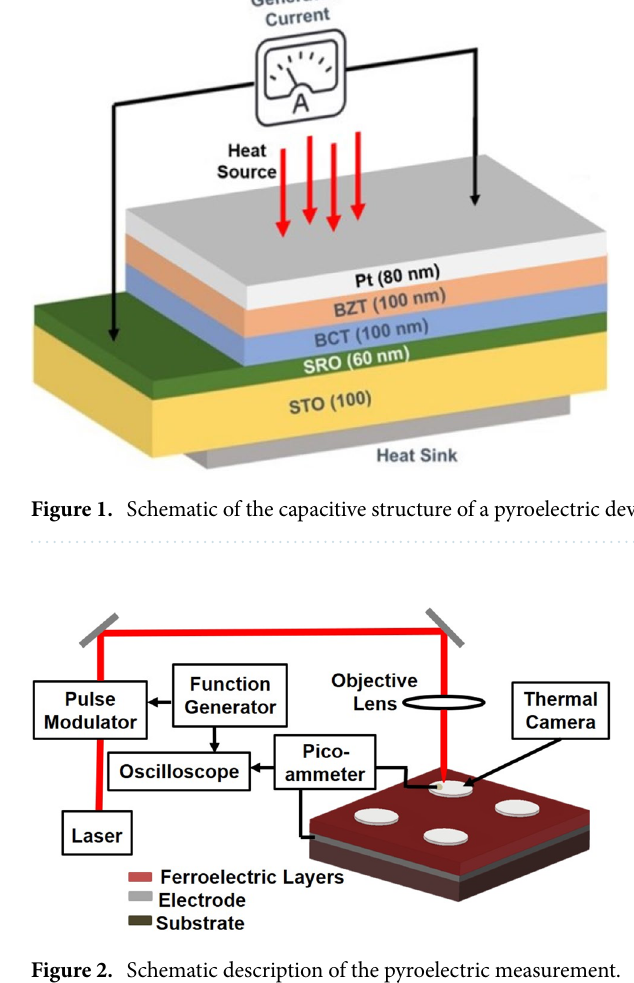
Figure 2. Schematic description of the pyroelectric